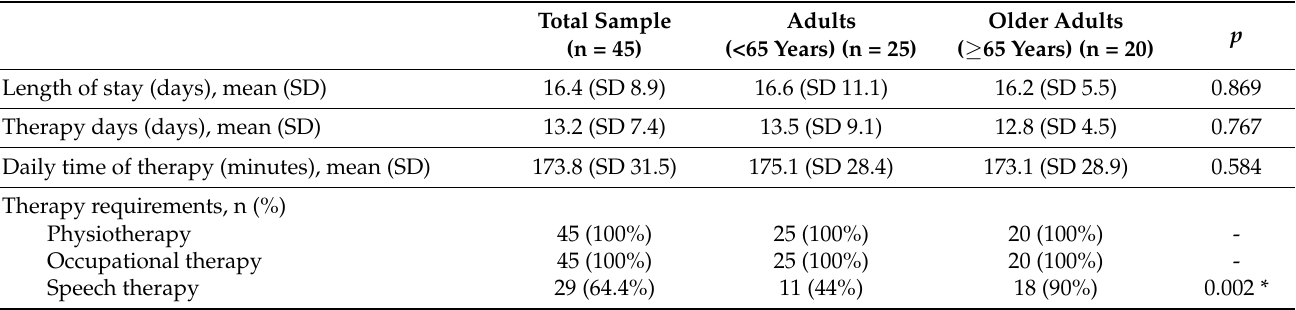
Table 3. Type and duration of therapies performed during stay in the intensive rehabilitation